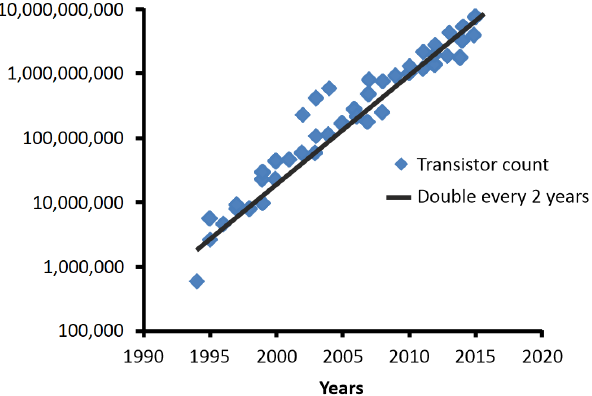
Figure 1. Chronological interpretation for last 30 years of the Moore’s law: transistor count on the VLSI chip is doubled every 2 years because the sizes of transistors are decreased.